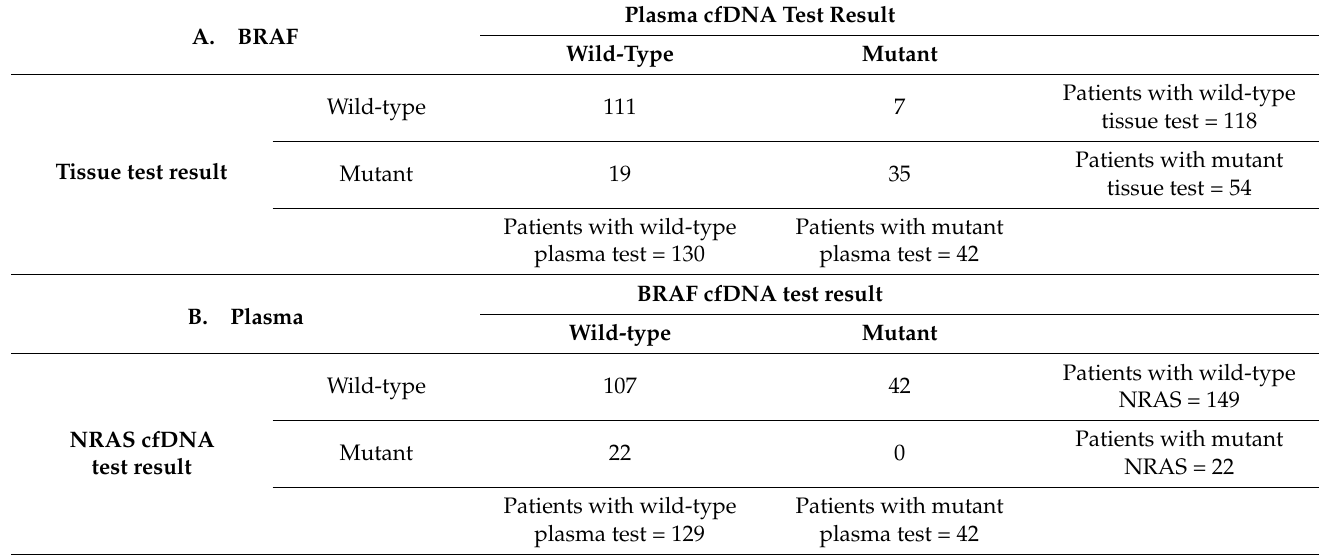
Table 2. Comparison of tissue-based and cfDNA-based mutation tests. ( A ) Comparison of plasma and tissue BRAF V600 mutation test results, and ( B ) comparison of BRAF and NRAS plasma mutation tests results in the mITT population. Grey-shaded cells designate the discordance between the respective tests. cfDNA, cell-free DNA; mITT, modified intention-